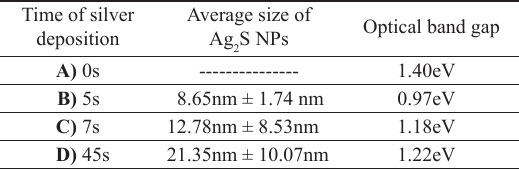
Table 1. Average NPs size and optical band gap of the electrodes.